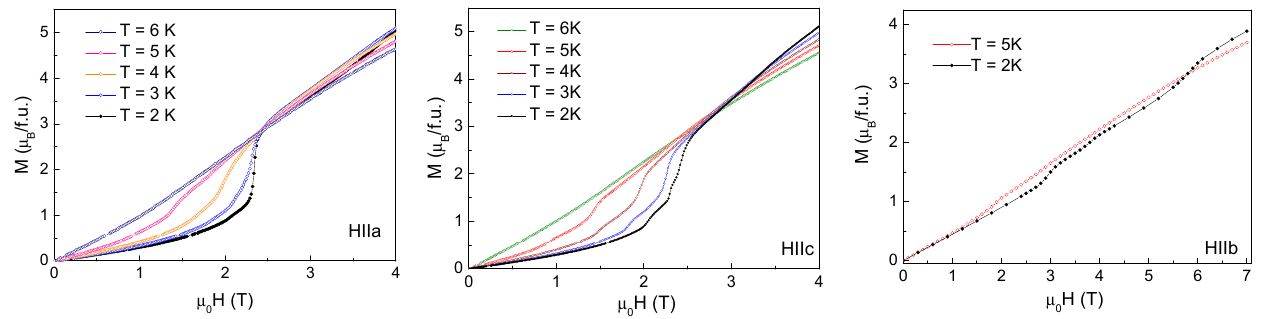
Figure 4. The field dependences of magnetization taken at various temperatures along principal axes in TbTe 3 .